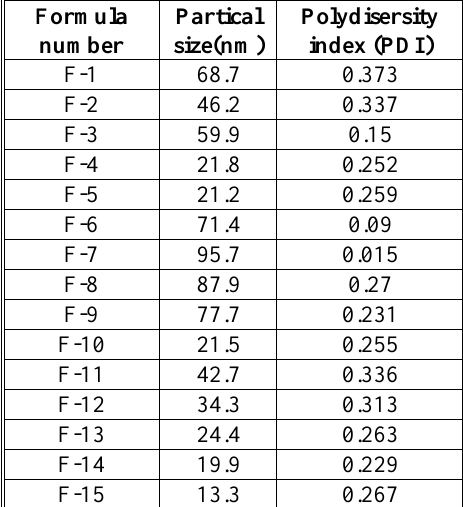
Table 6. Particale size and